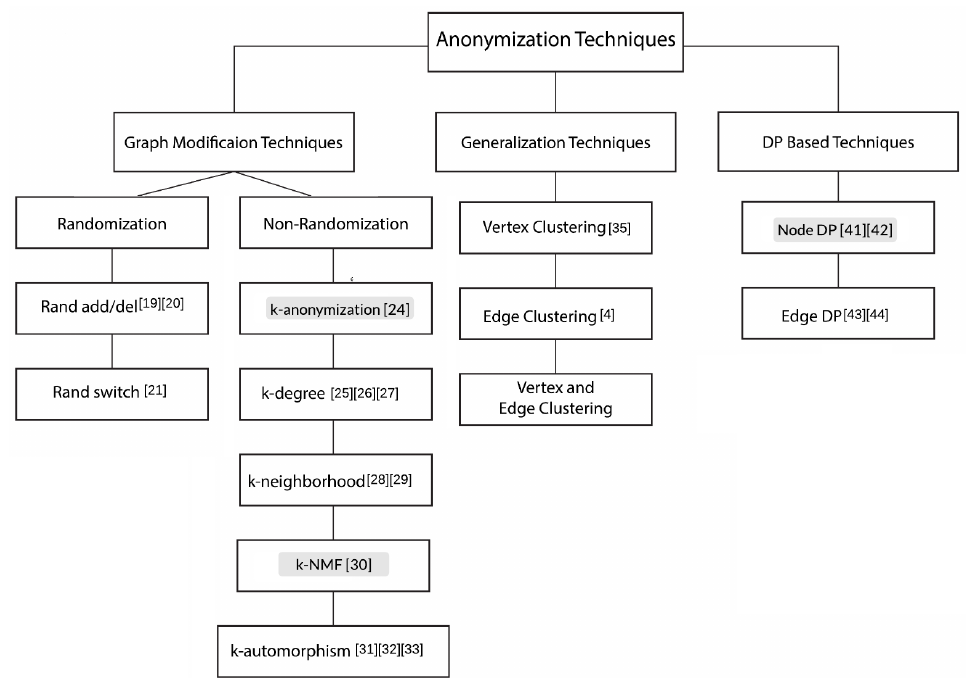
Figure 4. Anonymization techniques for social networks data